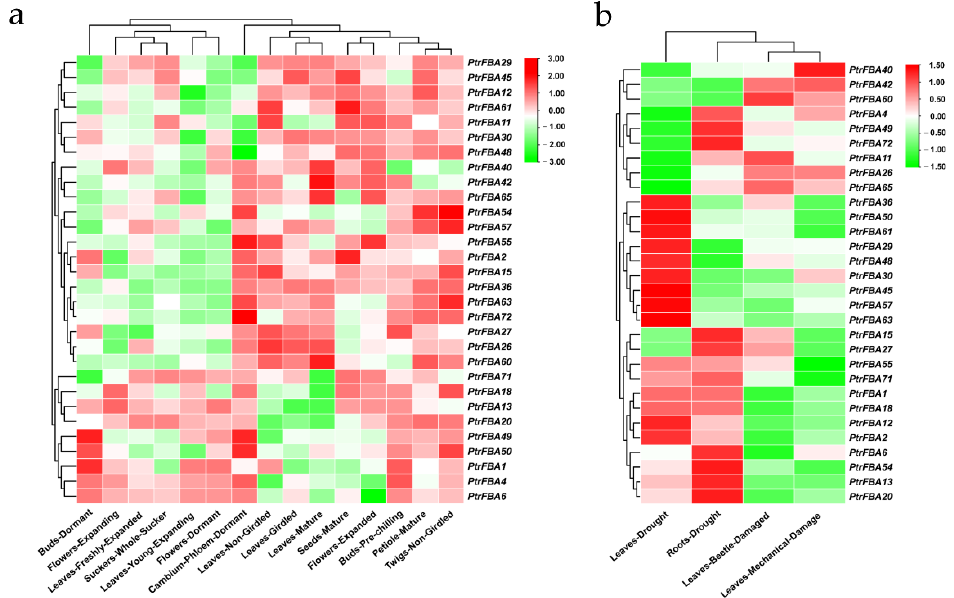
Figure 8. Expression profiles of PtrFBA genes under developmental and stress conditions. ( a ) The expression levels of 30 PtrFBAs genes in different tissues at different developmental stages are plotted based on transcriptome data. ( b ) A heat map of gene expression levels of 30 PtrFBAs following drought, beetle and mechanical injury. The color bar represents the range of maximum and minimum values of relative expressions in the heatmap. Red, white and green represent high, medium and low expression levels, respectively.